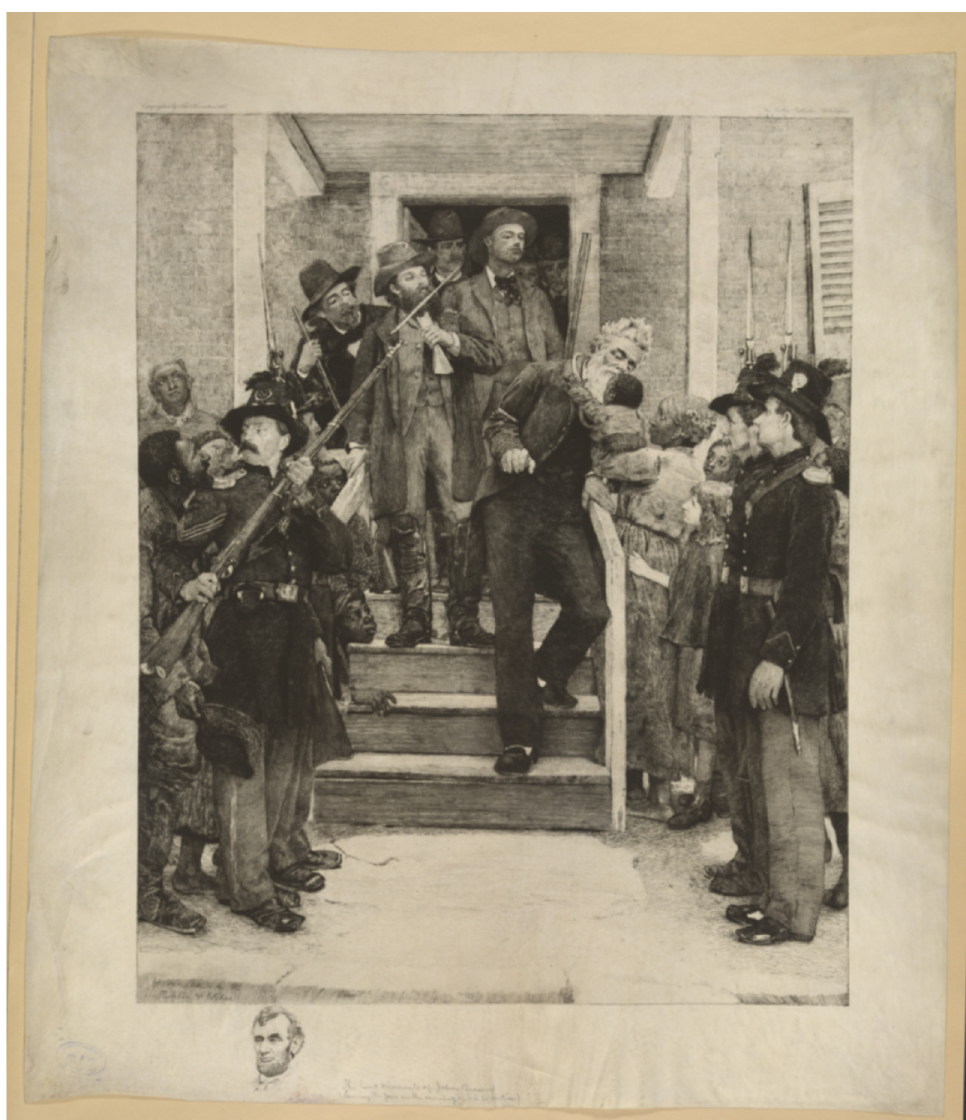
Figure 1. Thomas Hovenden, Etcher, and George Gebbie. The last moments of John Brown leaving the jail on the morning of his execution /Hovenden N.A., Painter & Etcher, ca. 1885. Philadelphia: Geo. Gebbie publisher, August 12. Photograph. Courtesy, Library of Congress. https://www.loc.gov/ item/2012648890/ (accessed on 5 May